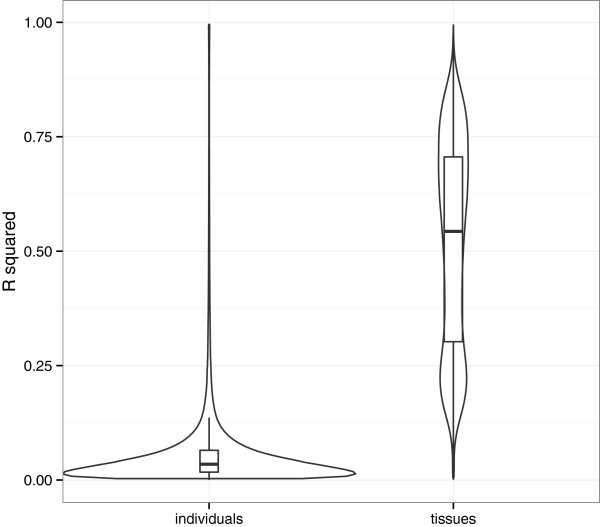
Variance explained by the tissues and individuals. Figure is showing the distribution of the R squared statistic obtained for each CpG site. It is clearly visible, that variance explained by the individuals is insignificant - on average individuals explain only 6.4% of the variance whereas tissues explain 51.2%.